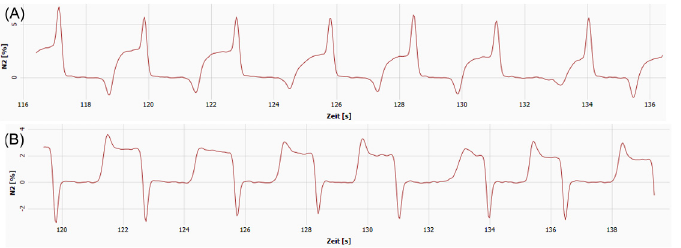
Fig 5. Distortion of the N 2 signal due to changes of the O 2 flow-offset setting. (A) Lowering the O 2 flow- offset setting from 618 to 578 ms (-7%) resulted in distorted N 2 signal in the last washout breaths, typically forming spikes at the end of expired signal trace and optionally divots at the end of inspiration. (B) Elevating the O 2 flow-offset setting from 618 to 658 ms (+7%) typically resulted in divots at the beginning of inspiration and optionally spikes at the beginning of expired N 2 signal trace.